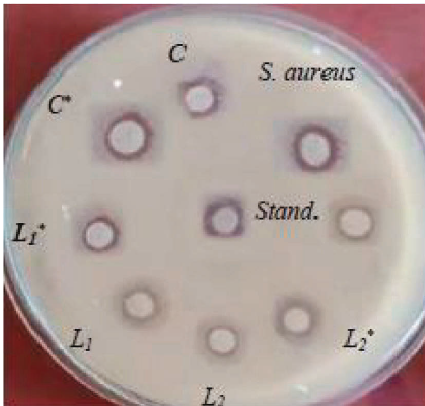
Figure 16: Distance moved by samples inhibiting the growth of S. aureus , where C and C ∗ and L and L ∗ are concentrations of the complex and ligands at 100 and 200 μ g/mL,